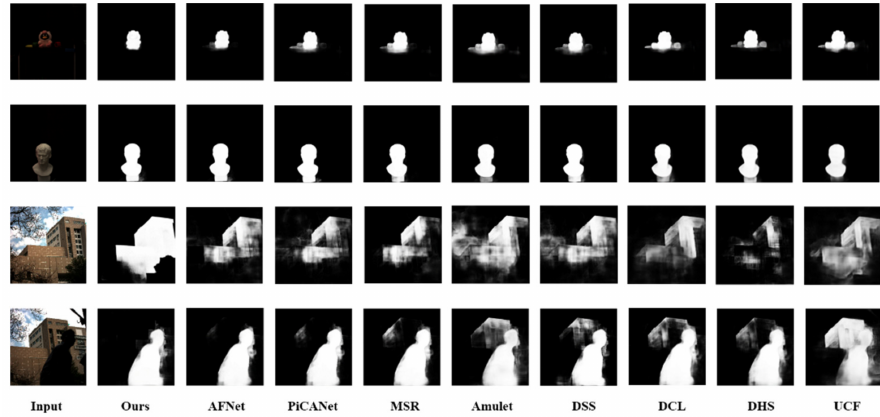
Figure 10. Results of salient object